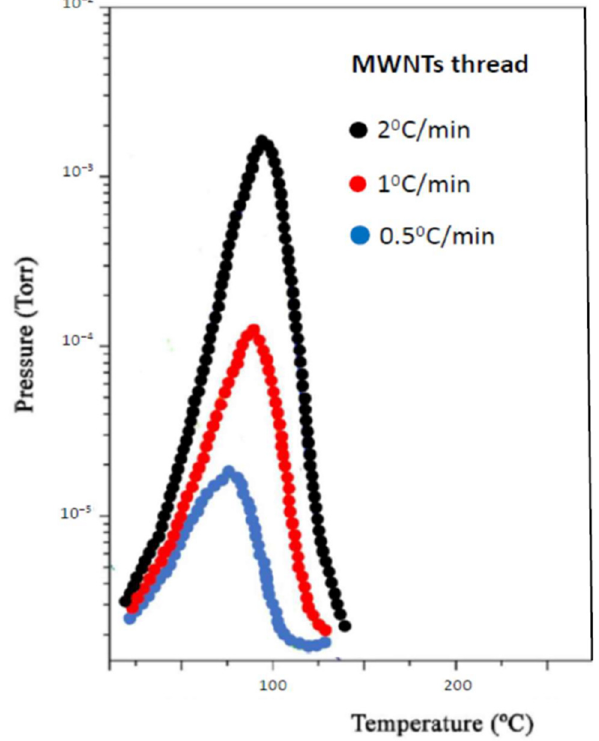
Figure 6. MB-TDS spectra of hydrogenated MWNT thread, taken at three different heating rates.